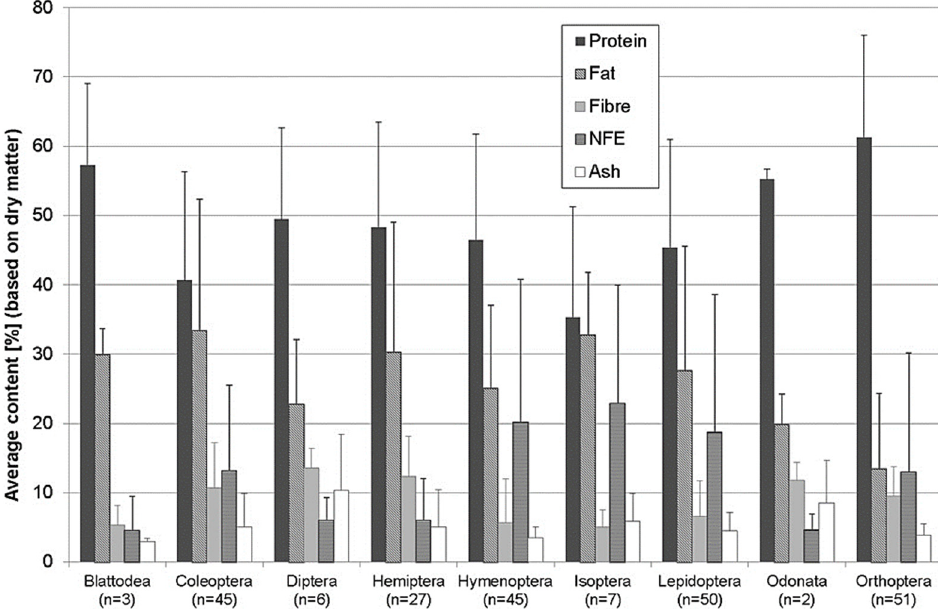
Figure 1. Average nutrient contents (%) (based on the dry matter) of edible insects belonging to the same order. n, number of insect samples obtained from literature; NFE, nitrogen-free extract [22].